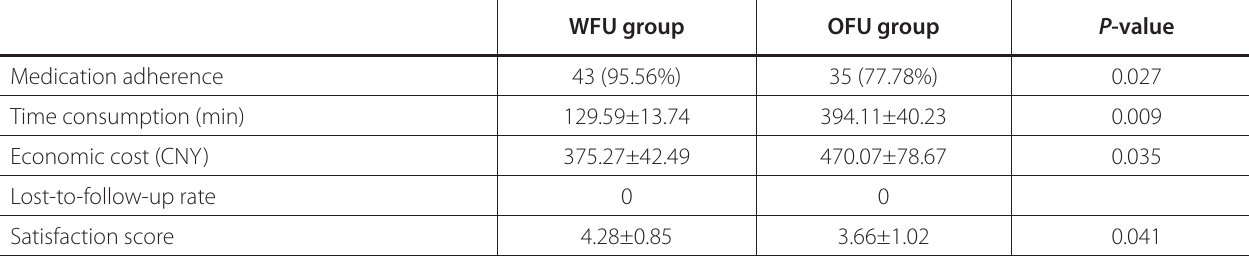
Table 2 . Comparison of the results between the two groups at the three-month